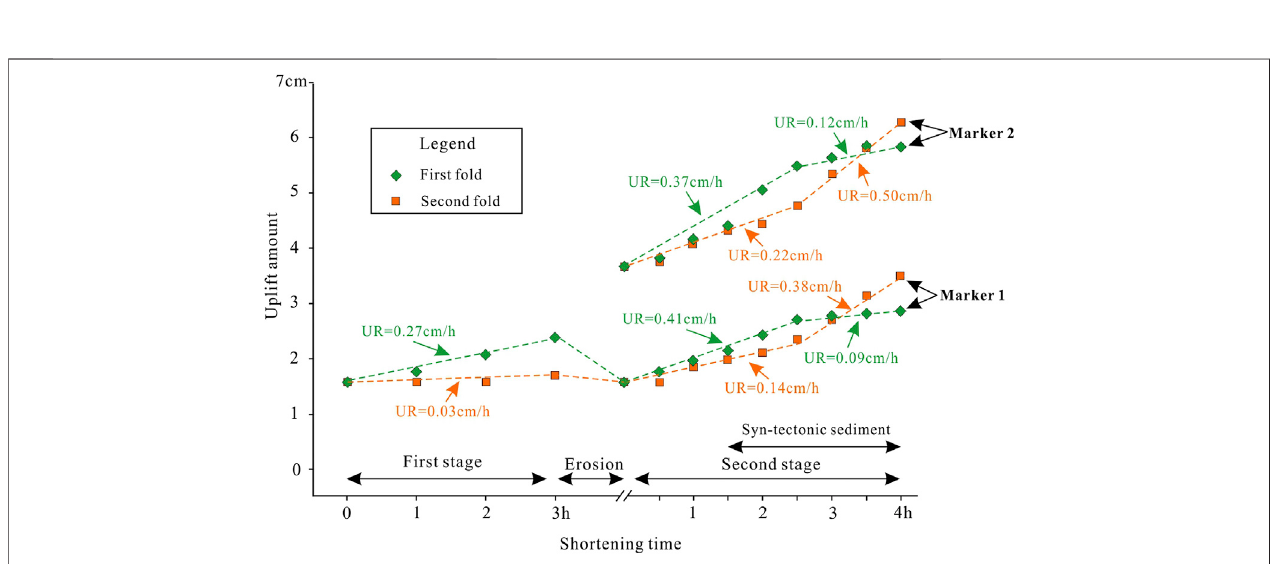
FIGURE9| Uplift-shorteningtimecurvesduringthetwostagesoftheshorteningexperimentshowtheupliftrate(UR)ofdifferentfoldsanddifferentlayers(Markers oneandtwolocatedbelowandabovesilicone,see Figure8 ).Asinthe fi rststage,theupliftrateofthe fi rstfoldis0.27 cm/h.Inthesecondstage,the fi rstfoldupliftrateis 4.1 cm/h at the fi rst 2.5 h and falls to 0.09 cm/h.